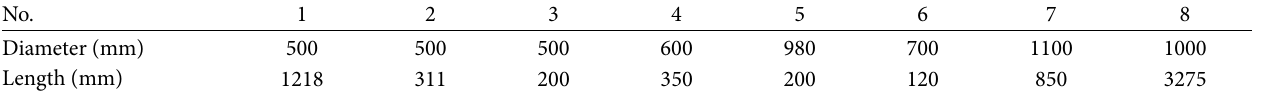
Table 2: The sizes of generator rotor segments.